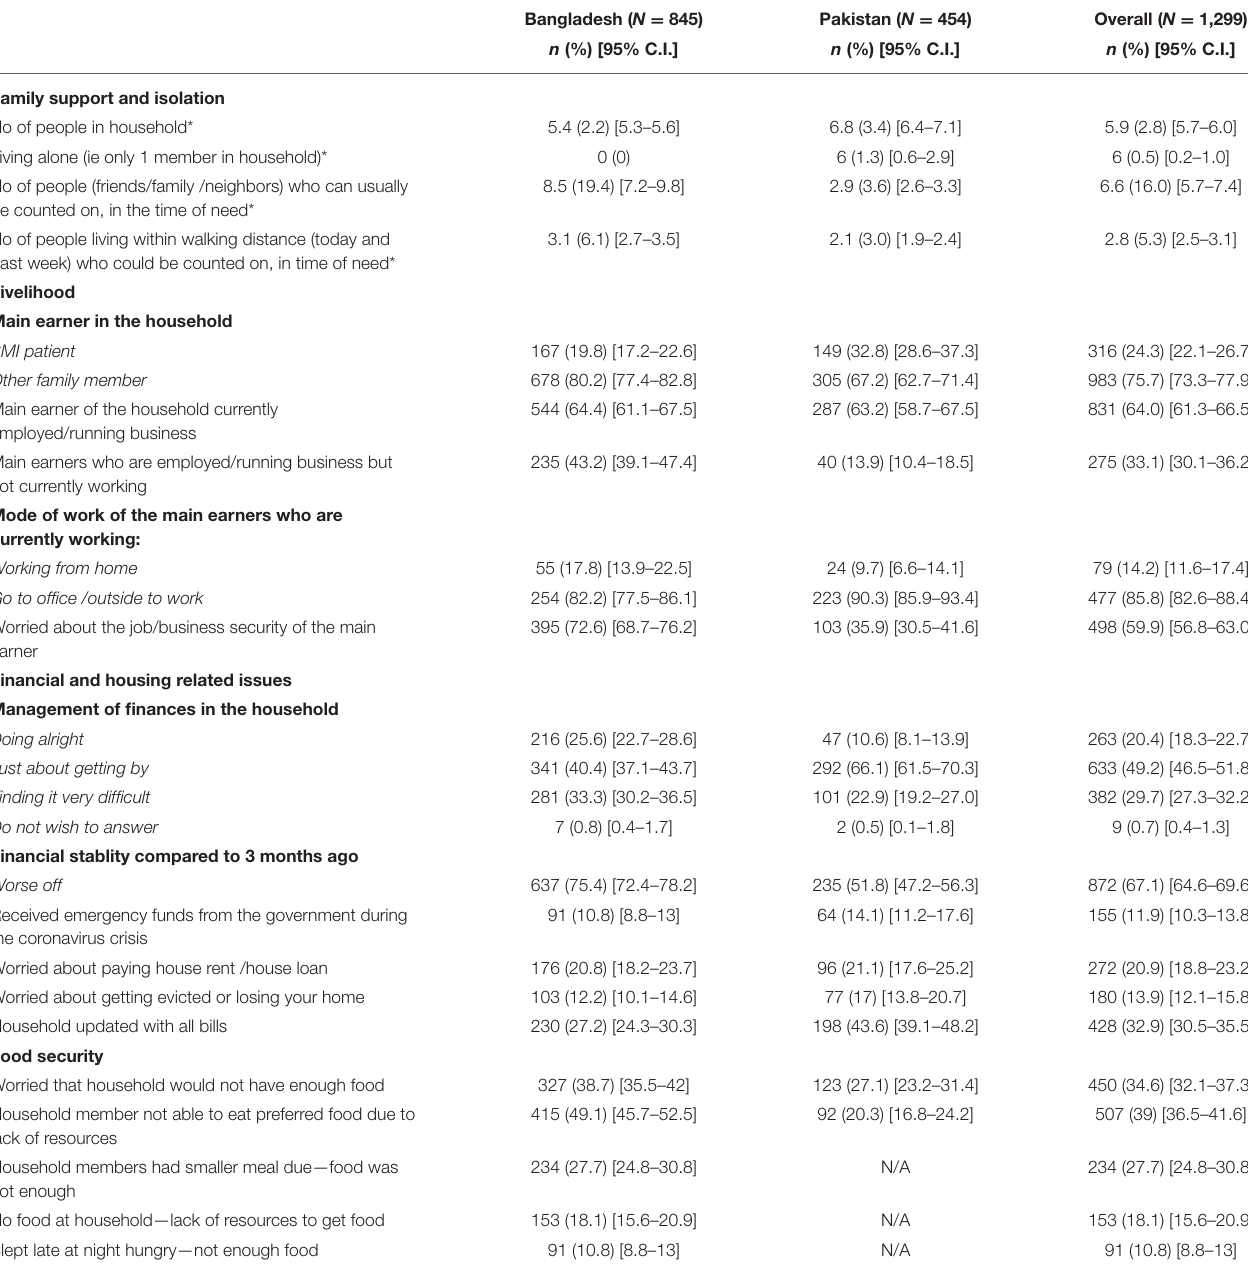
TABLE 6 | Family support and isolation, livelihood, financial, and housing related issues during the COVID-19 epidemic. Bangladesh ( N =